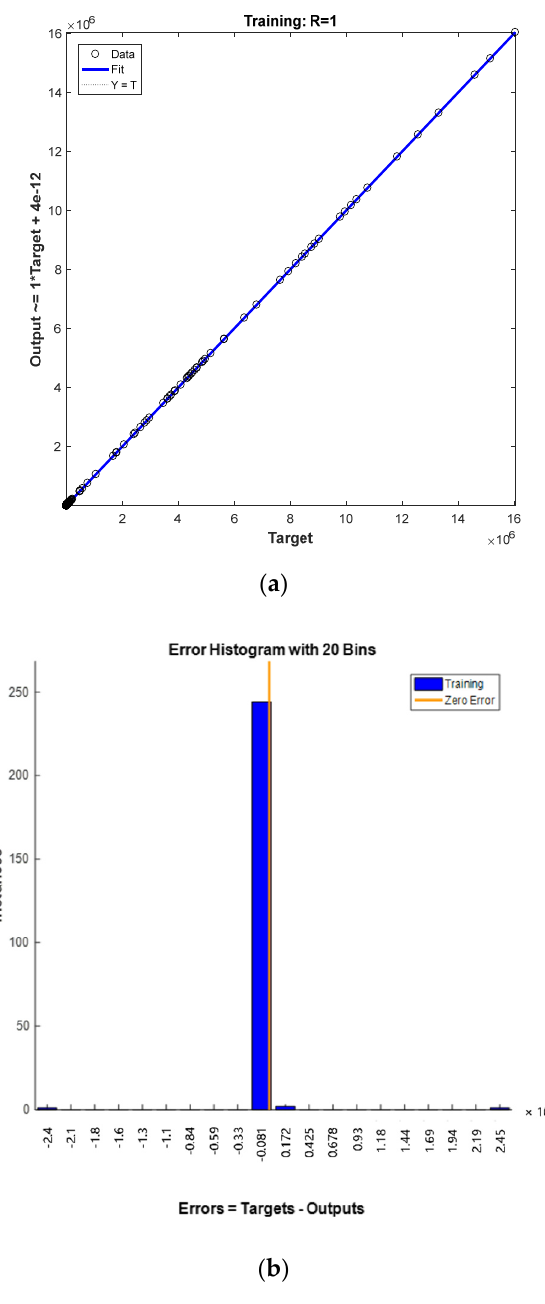
Figure A4. BP Neural network training regression and error histogram diagram. ( a ) Regression diagram. ( b ) Error histogram.